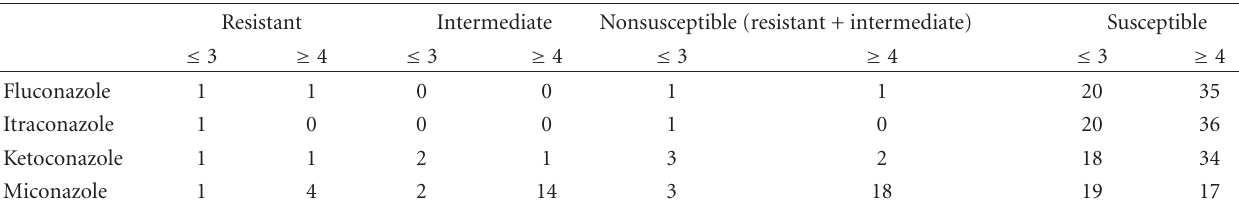
Table 3: Azoles susceptibility pattern of Candida spp. isolated from vagina of women with or without vulvovaginitis with previous micona- zole treatment ( ≤ 3 or ≥ 4 times). Total number of isolates = 57 (consisting of 22 and 35 isolates from women taken miconazole ≤ 3 and ≥ 4 times, respectively, during the last year before taking the samples). When the two groups ( ≤ 3 and ≥ 4) were compared as to miconazole nonsusceptibility, the P value was <